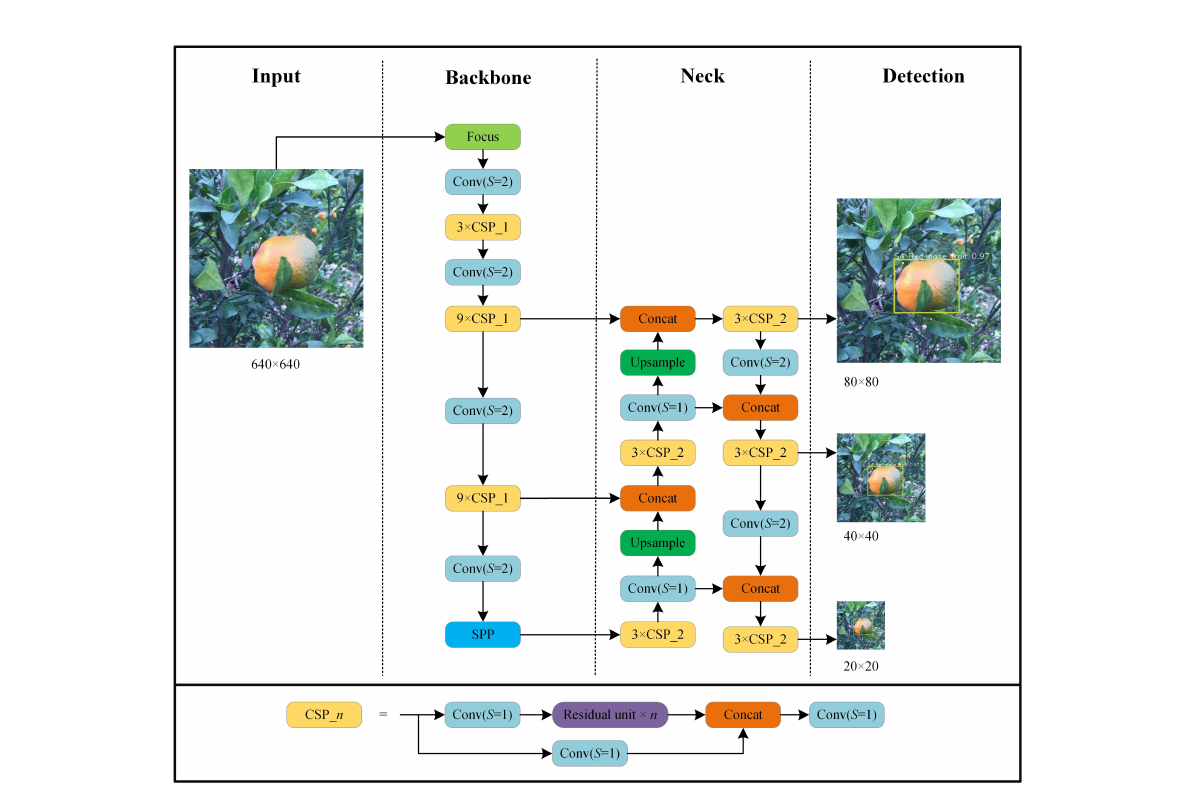
FIGURE 3 Architecture of YOLO v5l network used in this study. Focus is lossless down sampling. Conv (S=2) denotes convolution with a step size of 2 and a convolution kernel size of 3×3. Conv (S=1) uses a fi lter with a size of 1×1 and convolution with a step size of 1. CSP_n denotes a convolution module integrated with n residual units. SPP denotes spatial pyramid pooling. Concat is the feature map fusion operation. Upsample is the upsampling operation.